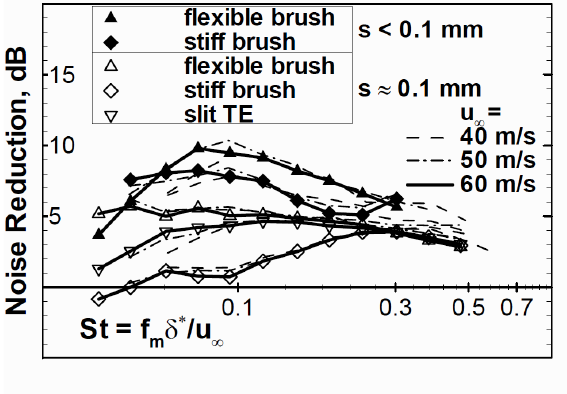
Figure 15. Effect of fiber spacing s on the noise reduction of NACA 0012-like airfoil, reprinted from [148] with permission from